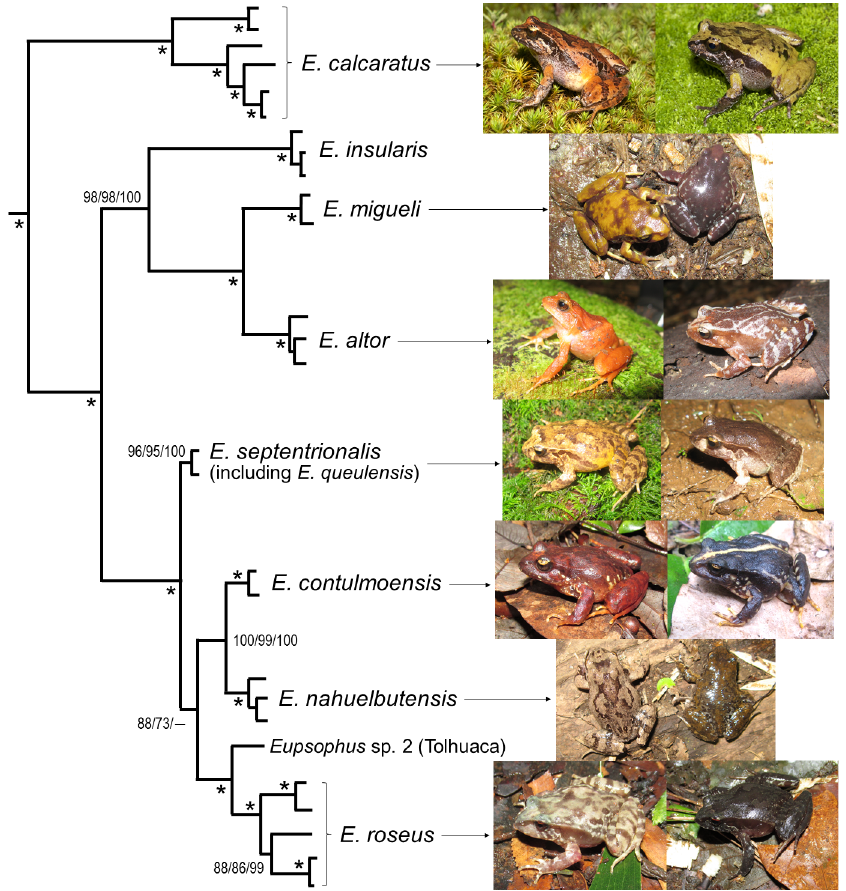
Fig 1. Phylogenetic relationships after Blotto et al. ([18], their Fig 2) and variation of body coloration of the Eupsophus roseus group. The tree depicts the relationshipsamong the eight currently recognized species of the group plus a probableundescribed species (sp. 2) from Tolhuaca, Chile, accordingto the parsimony analysisof Blotto et al. [18]. Numbers along nodes separated by slashesindicate jackknife values of the two different maximum parsimony analysesand posterior probabilities of the Bayesian analysisof Blotto et al. [18]; asterisks indicate maximum values of jackknife and posterior probabilities; the hyphen denotesa group not recovered in their analyses. The relative lengthsof the branches of the originalfigure were maintained.Pictures exemplifyintrapopulation variationof body colorationin specimensfrom the type localities (excepting E . insularis ):Chiloe´ Island ( E . calcaratus ), Mehuı´n ( E . migueli ),Parque Oncol ( E . altor ), R.N. Los Queules ( E . septentrionalis ),M.N. Contulmo ( E . contulmoensis ), P.N. Nahuelbuta ( E . nahuelbutensis ) and Valdivia( E . roseus )(see maps of Fig A in S5 File).